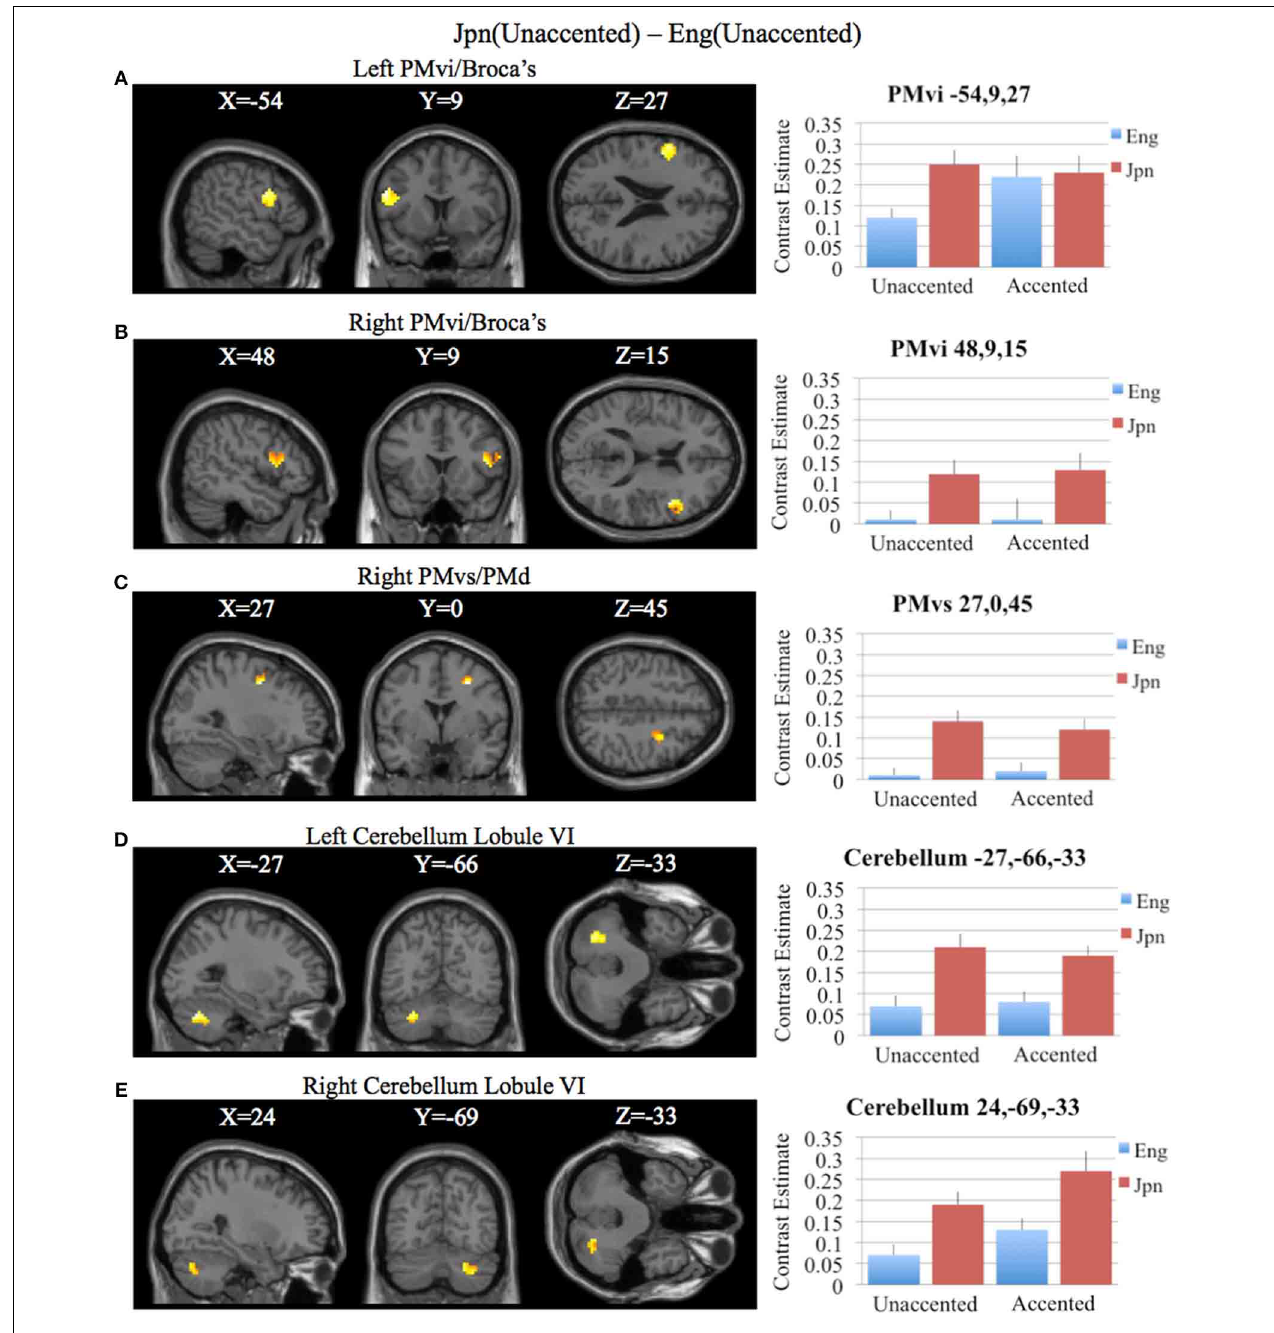
FIGURE 7 | Region of interest analysis for the contrast of Jpn(unaccented) – Eng(unaccented) using small volume correction ( p < 0 . 05) for multiple comparisons. (A) Left PMvi/Broca’s area. (B) Right PMvi/Broca’s area. (C) Right PMvs/PMd. (D) Left Cerebellum Lobule VI. (E) Right Cerebellum Lobule VI. MNI X, Y, Z coordinates